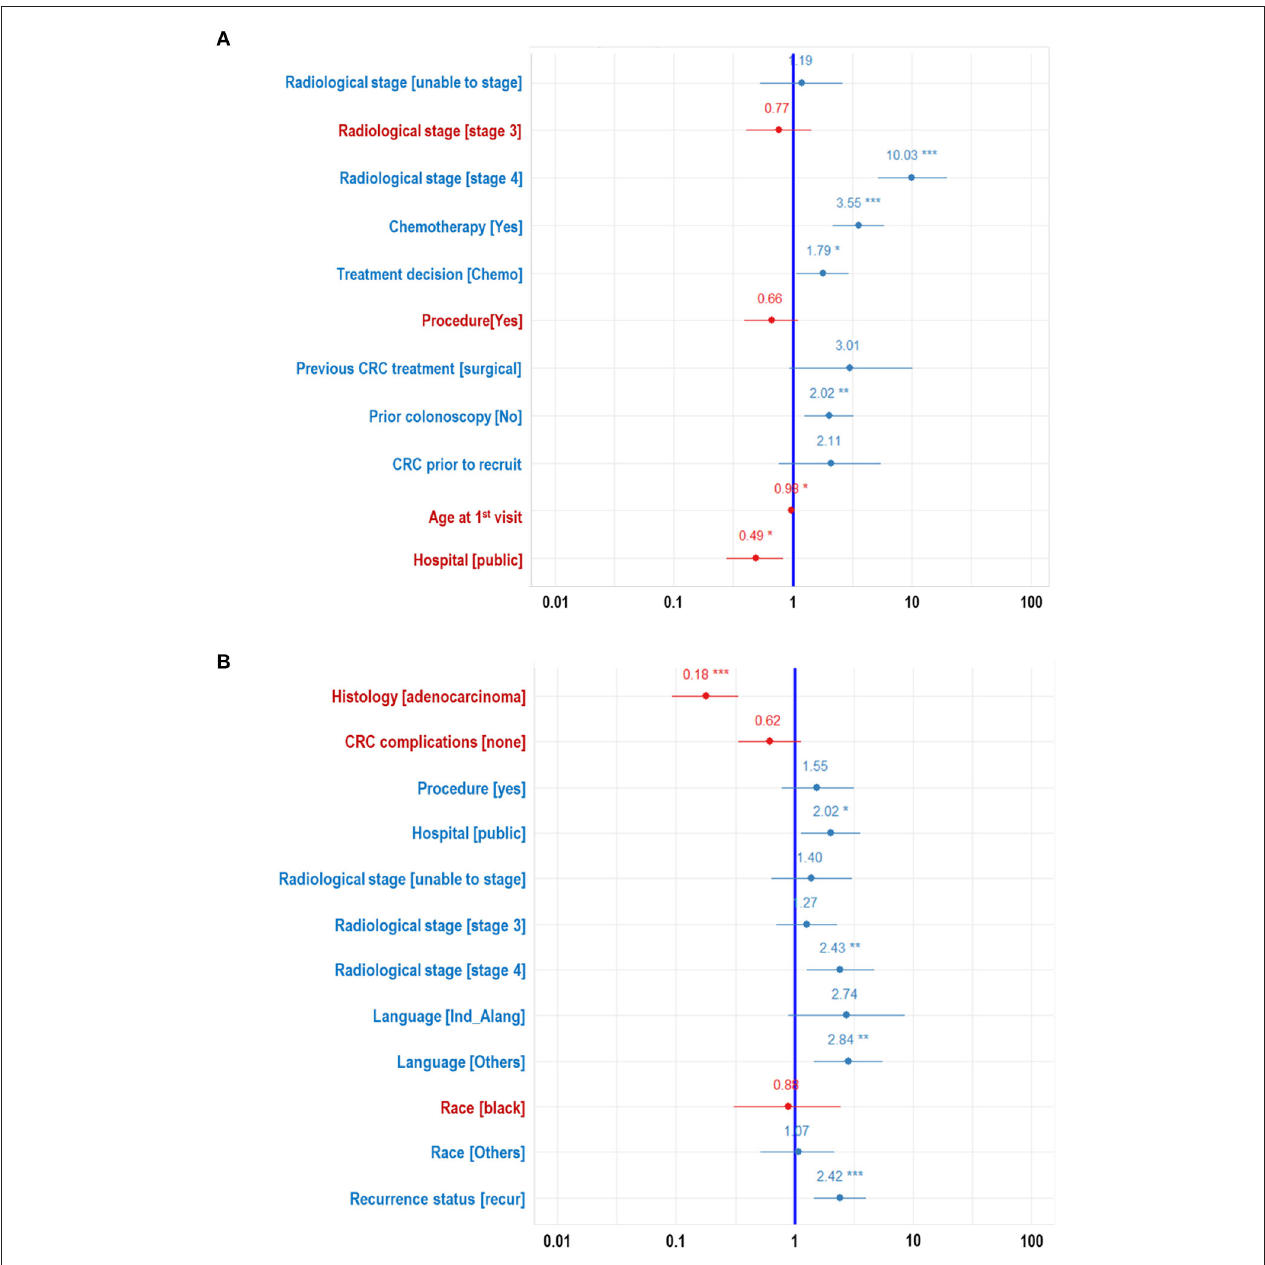
FIGURE 2 | Forest plots developed from logistic regression showing the effects of each features on the WDGMC CRC (A) recurrence and (B) survival. Features with significance effects are shown with asterisks. Features with their effects values written in red letters decrease odds of CRC recurrence or CRC survival.